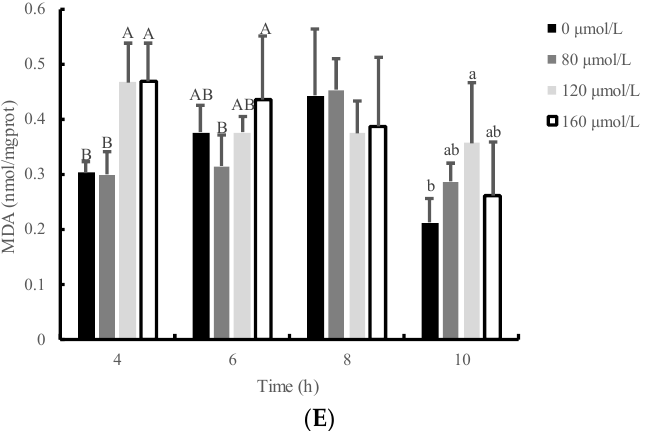
Figure 3. The effects of H 2 O 2 concentration and action time on the antioxidant capacity of IPEC-J2 cells. Cellular antioxidant capacity is mainly reflected by the following indicators: ( A ) T-AOC, ( B ) CAT activity, ( C ) T-SOD activity, ( D ) GSH-PX activity, ( E ) MDA content. Note: This figure shows the effects of different concentrations of H 2 O 2 (0, 80, 120 and 160 μmol/L) on the antioxidant performance of IPEC-J2 cells at different times (4, 6, 8 and 10 h). At each time point, compared with the 0 μmol/L group, the difference was significant for different lowercase letters ( p < 0.05), the difference was extremely significant for different uppercase letters ( p < 0.01), and the difference was not significant for no letters or the same letter shoulder label ( p > 0.05).